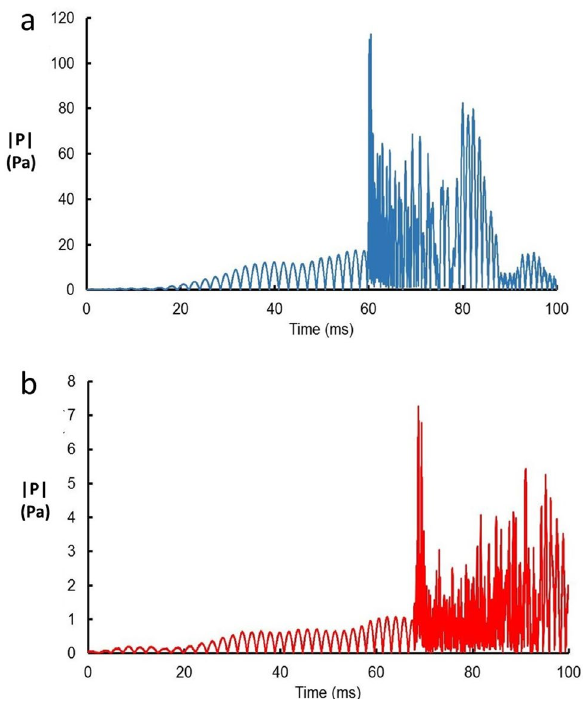
Figure 1. Absolute rectified value of the pressure from calibration shots at a sensor ( a ) at 3100 m and ( b ) 4100 m distance from a 5-m length of PETN primer cord depositing 260 kJ/m energy/length. The cord extended vertically from the surface to the lake bottom.